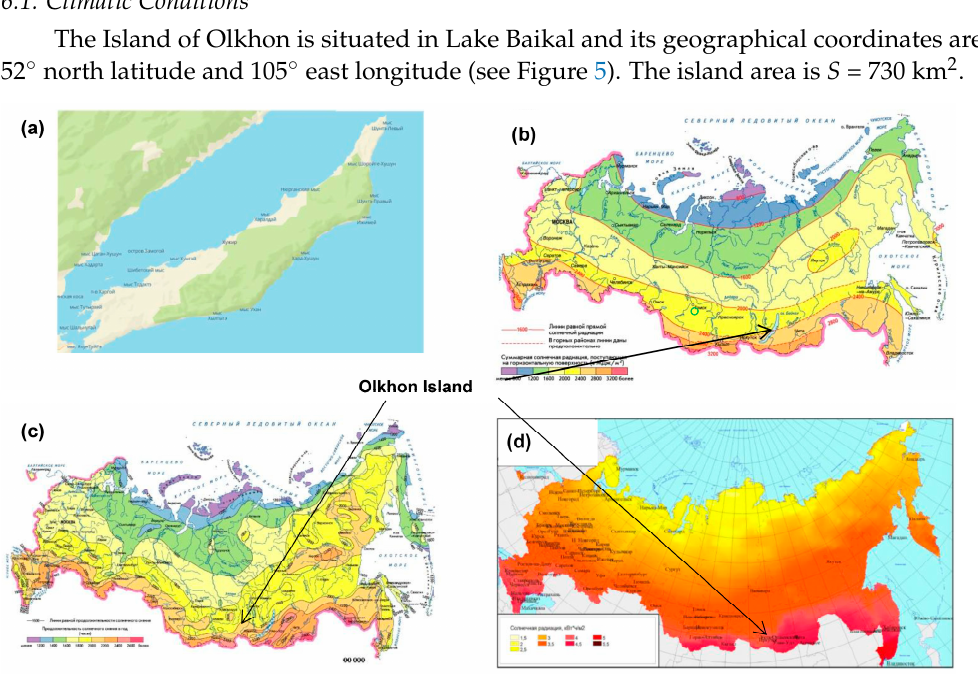
Figure 5. ( a ) Map of Olkhon Island. ( b ) Average annual total solar irradiation on a horizontal surface. ( c ) Average duration of sunshine per year. ( d ) Average annual total solar irradiation on an inclined surface. Table 2. Direct and diffuse solar irradiation on horizontal surfaces during a 10 h period (from 07 a.m. to 05 p.m.) on clear and partly overcast days, and surface albedo, ρ , by month.